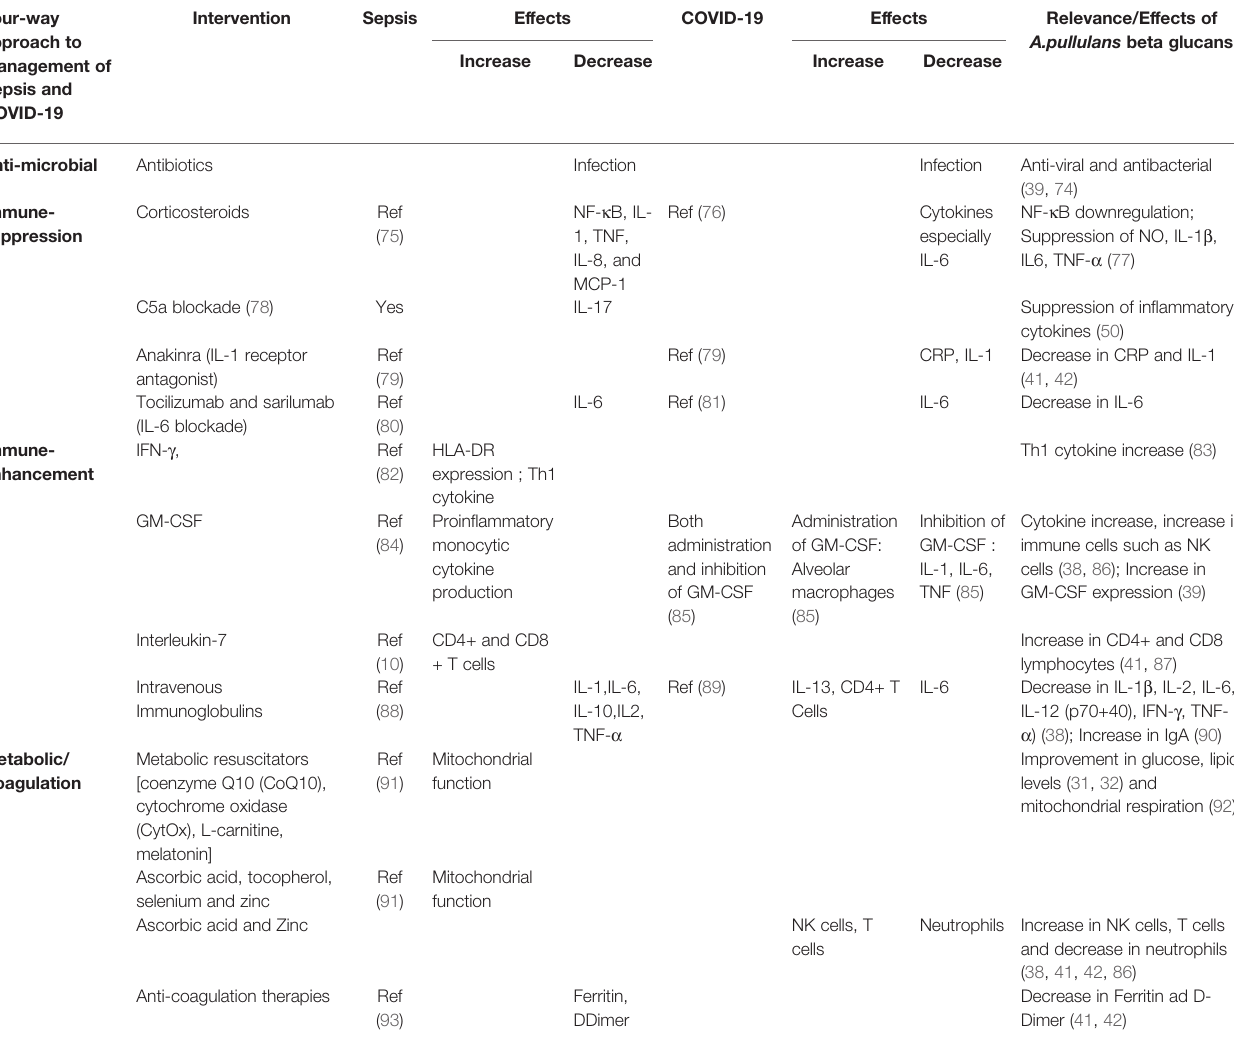
TABLE 1 | Four-way approach to interventions in sepsis, COVID-19, and the relevance of A. pullulans b -glucans whose effects cover the effects produced by the other interventions. Four-way approach